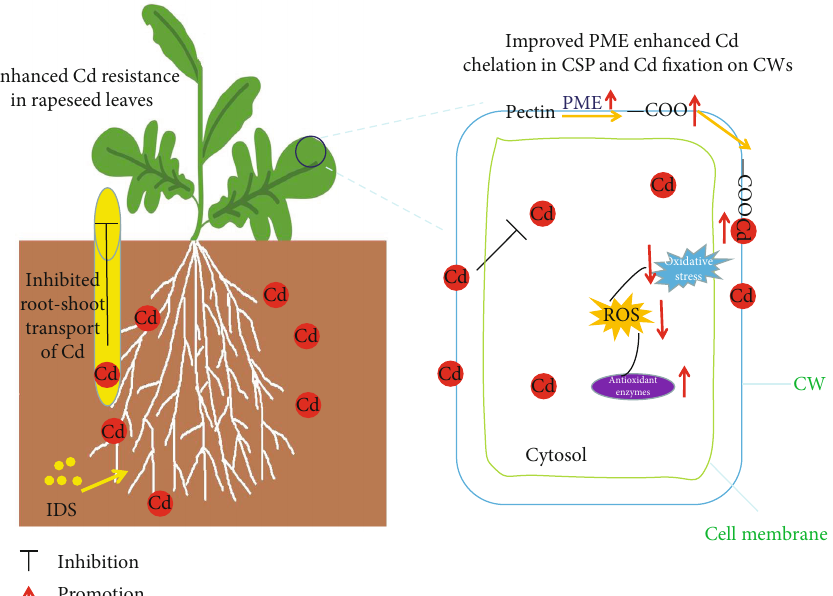
Figure 5: The schematic diagram illustrating the e ff ects of IDS on cell wall components in determining Cd tolerance in leaves of